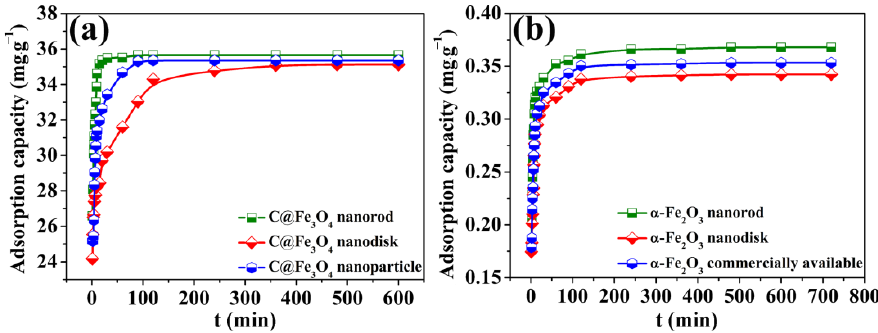
Figure 8. Time-dependent removal of MB by three C@Fe 3 O 4 composites ( a ) and α -Fe 2 O 3 precursors ( b ).